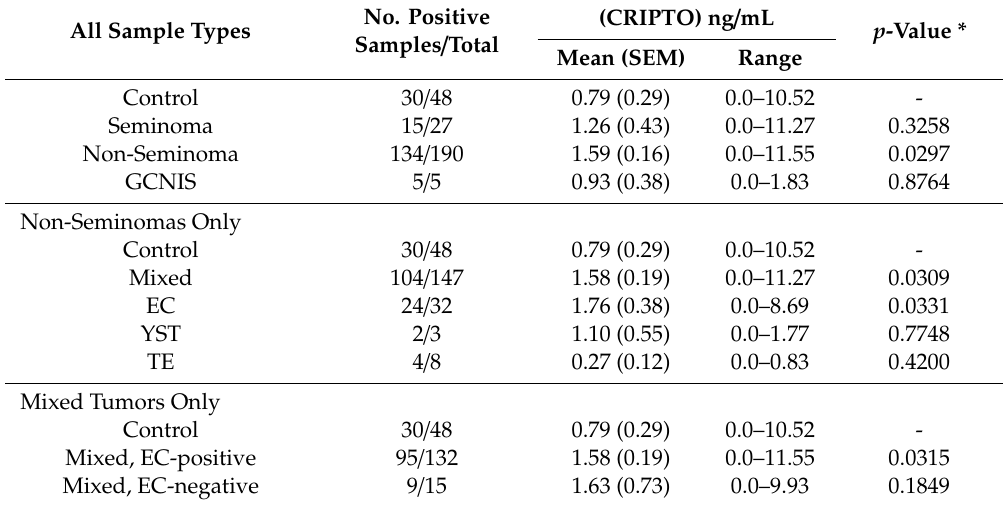
Table 1. CRIPTO concentration, according to histology in the serum